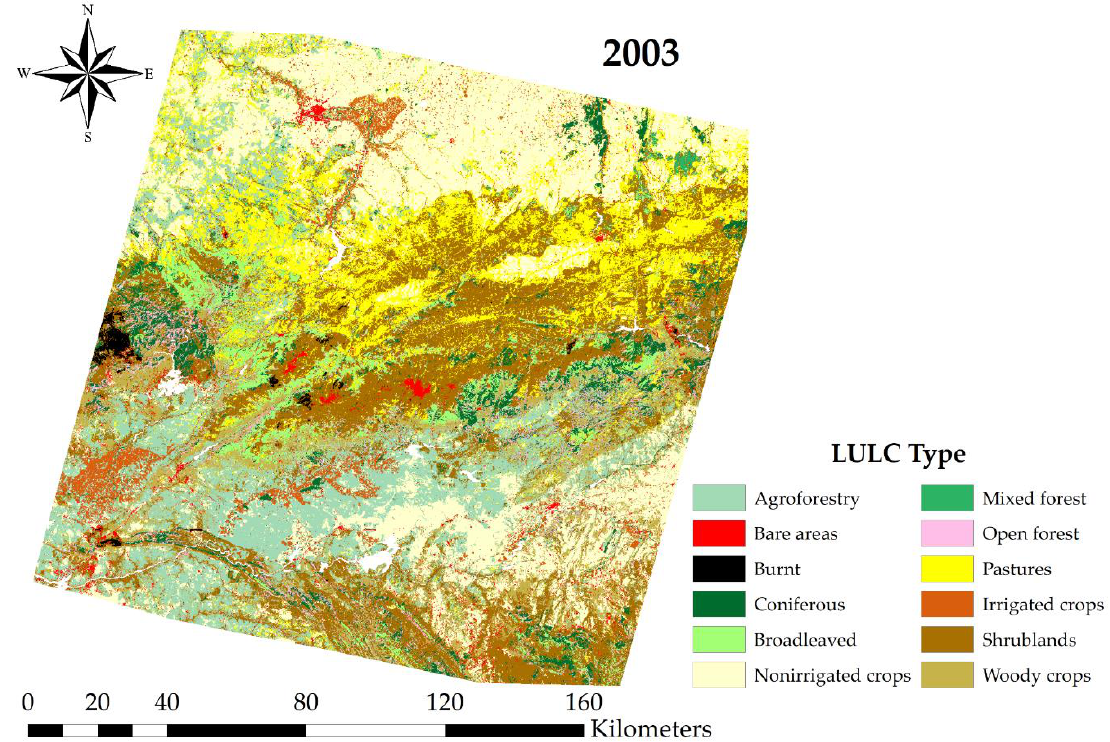
Figure A3. LULC map for 2003.